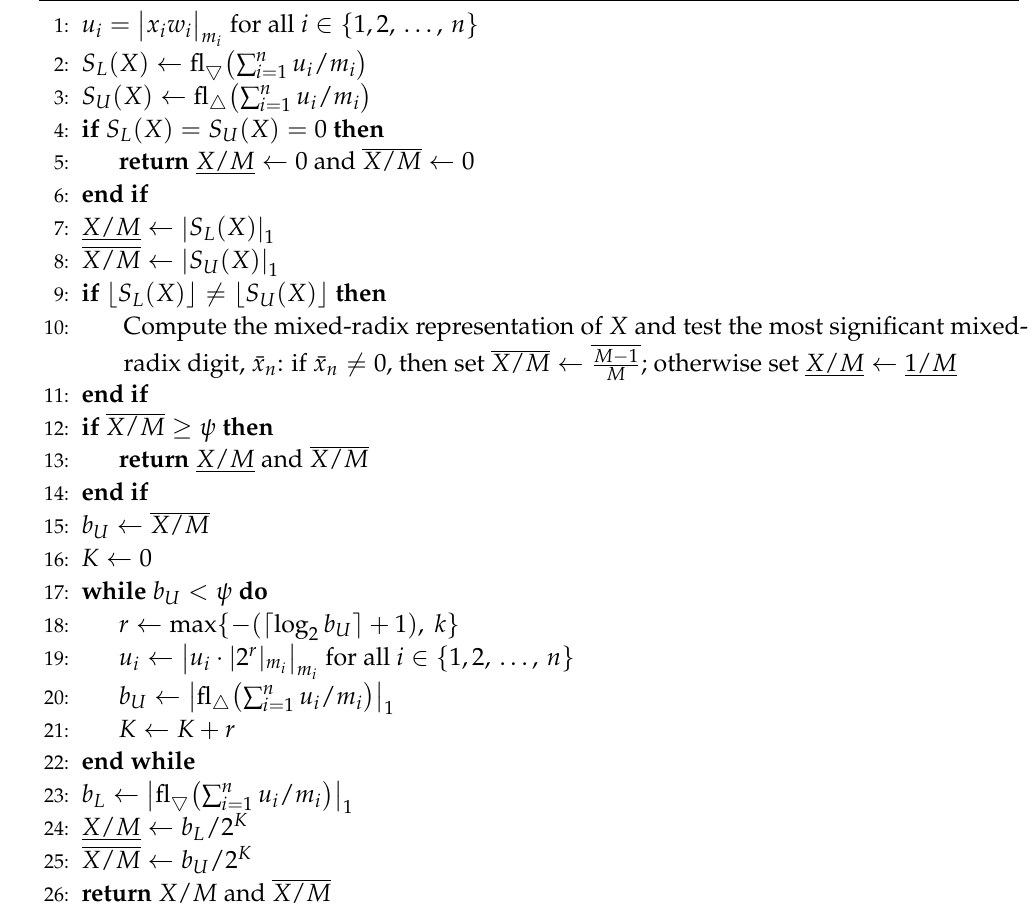
Algorithm 1 Computing the floating-point interval evaluation for an RNS